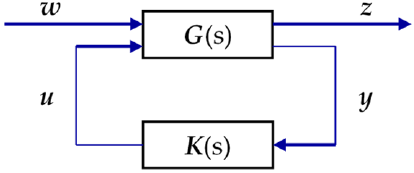
Figure 5. H 2 and H ∞ control block diagram.